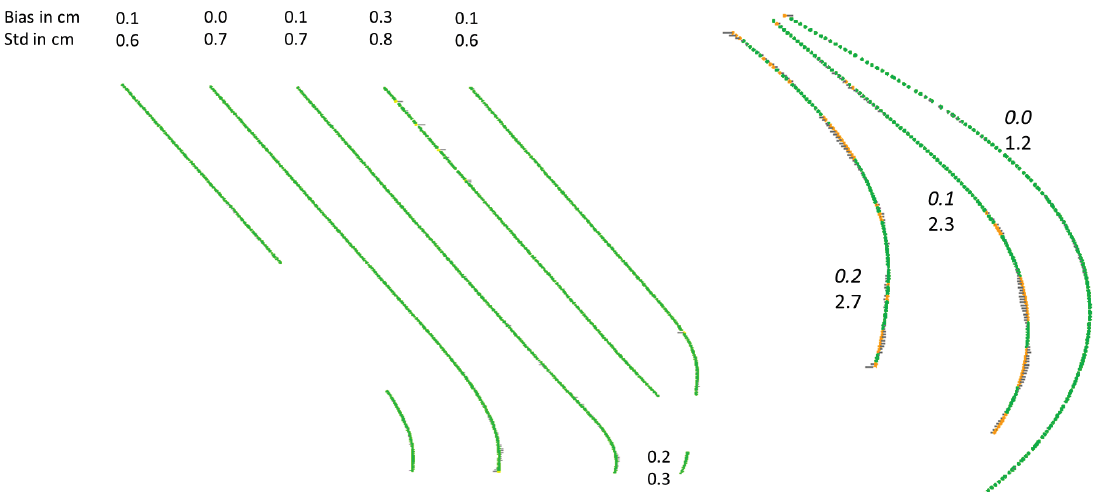
Figure 13. Differences between data-driven and model-driven approach in Blerick ( left ) and Sittard ( right